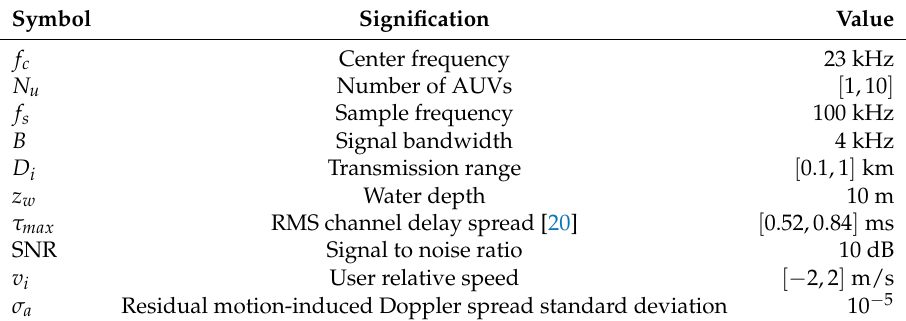
Figure 4. Evolution of the simulated time-varying channel impulse response over one frame based on the parameters provided in Table 1. Table 1. Underwater Acoustic (UWA) channel model parameters.